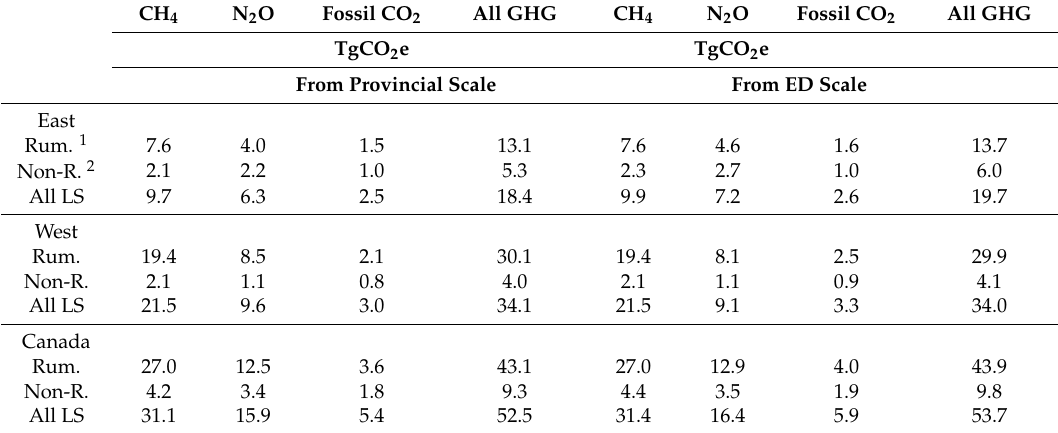
Table 3. Greenhouse gas emissions (GHG) from livestock estimated from provincial census data (Dyer and Verg é , 2015) and from Ecodistrict scale data for Eastern and Western Canada for 2006. CH 4 N 2 O Fossil CO 2 All GHG CH 4 N 2 O Fossil CO 2 All GHG TgCO 2 e TgCO 2 e From Provincial Scale From ED